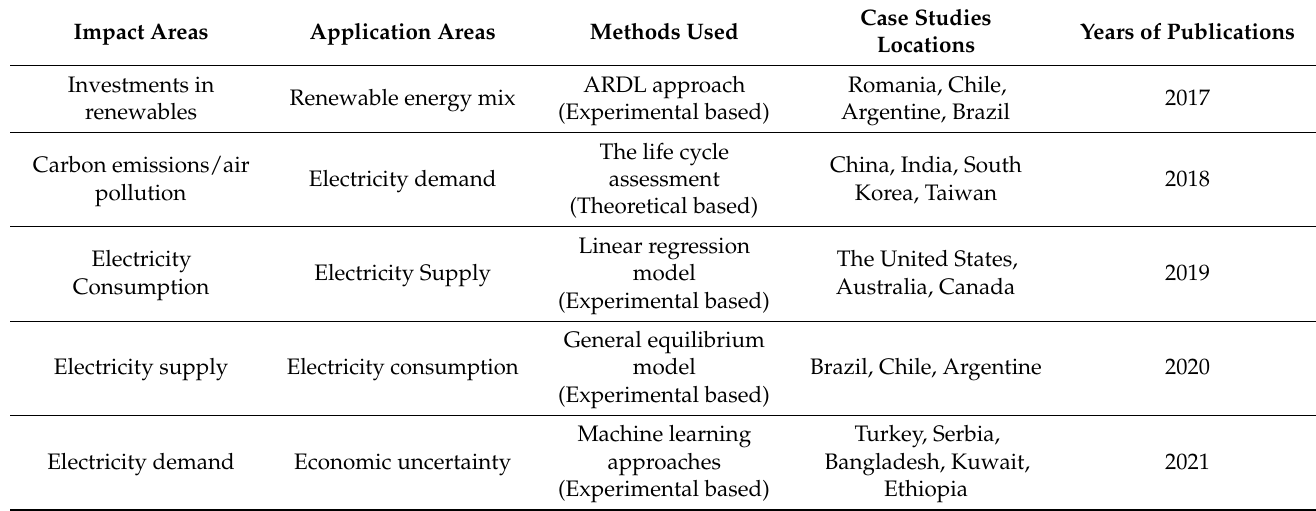
Table 1. A general description of the reviewed